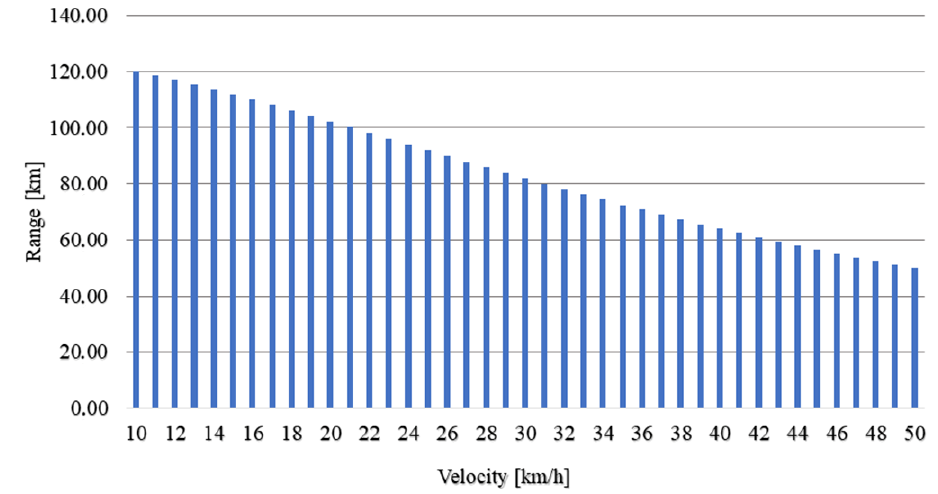
Figure 6. Range of HEV tested on AGM energy source.